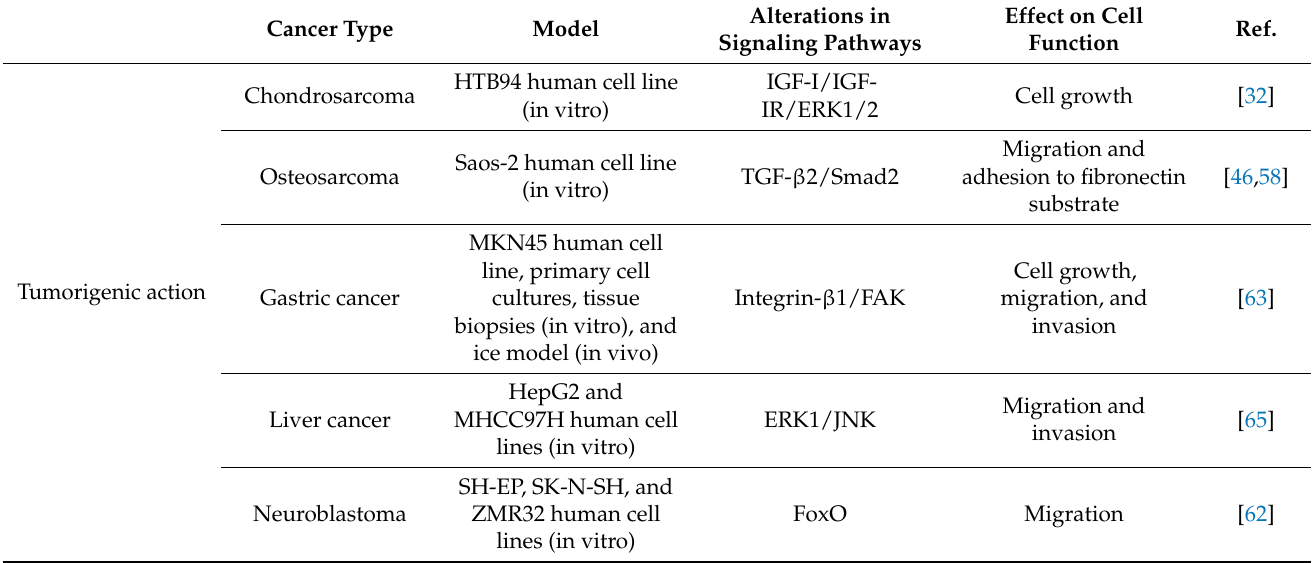
Table 2. Lumican’s role in various cancer types and the mechanism of action. Alterations in Cancer Type Model